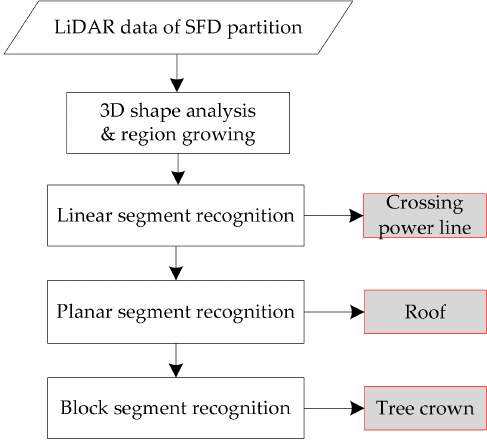
Figure 7. Flowchart of SFD partition